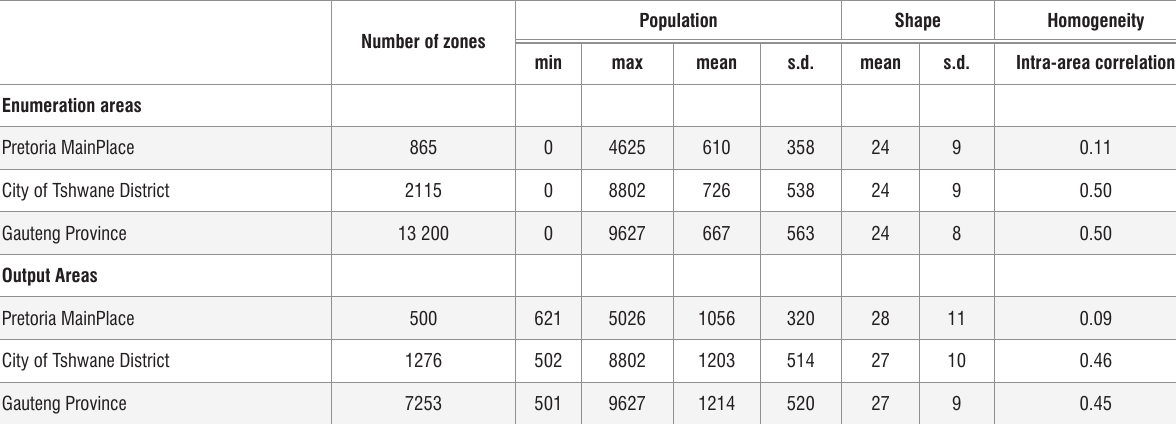
Table 3: Statistical characteristics of enumeration areas and output areas at various geographical levels for urban